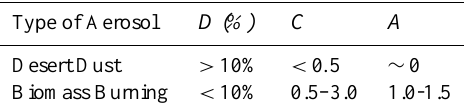
Table 1. Classification of desert dust and biomass burning aerosol depending on Volume Depolarization Ratio ( D ), Color Index ( C ) and ˚Angstr¨om coefficient ( A ) values.